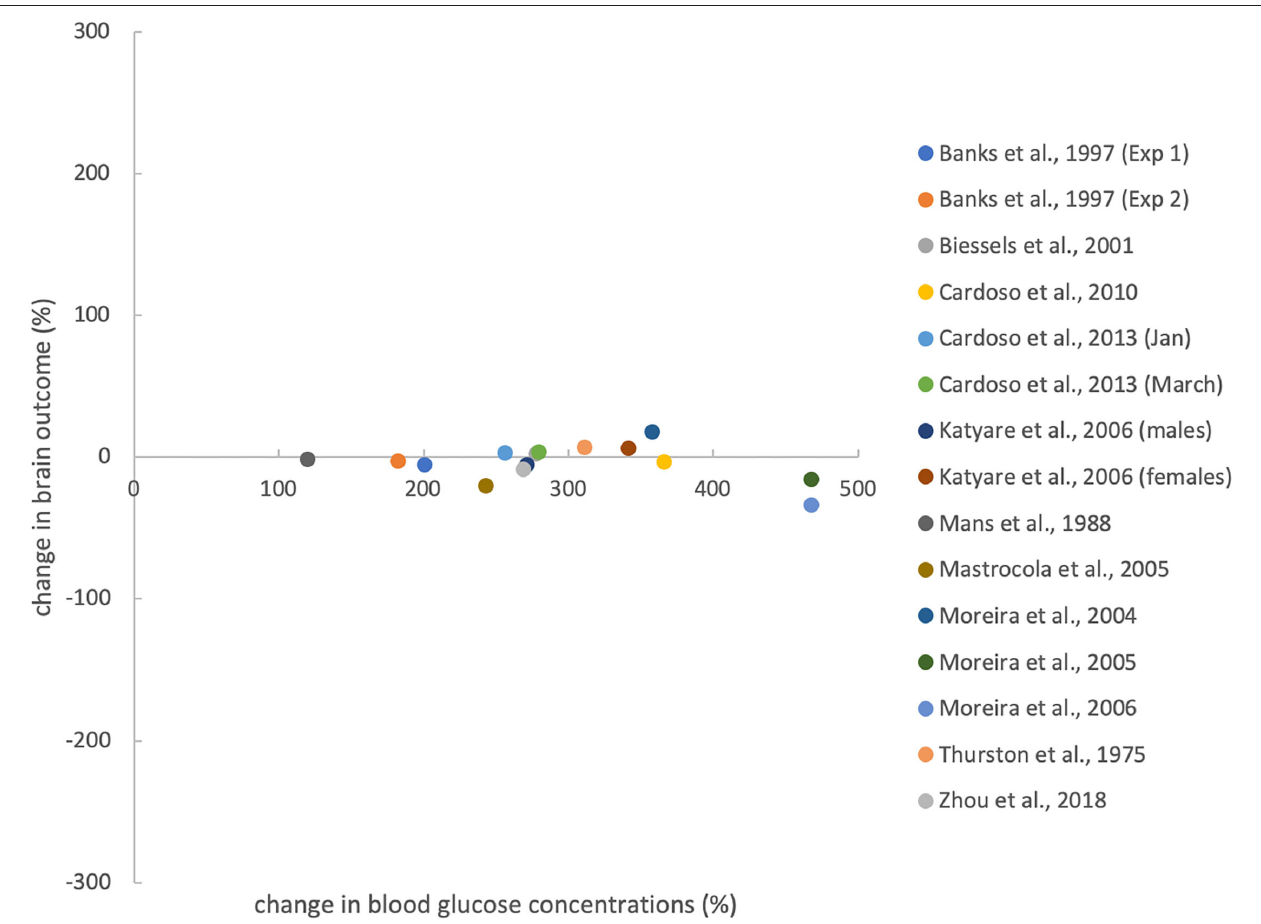
FIGURE 4 | Effects of T1DM induction on percentage change in blood glucose concentration (compared with controls) and brain outcomes. Brain outcomes include brain mass and brain ATP concentrations. Percentage changes were calculated from the data shown in Table 1 . For evaluating Zhou et al.’s work, we pooled brain volume data from 2 groups that differed in cognitive function. Anaesthesia before ATP measurement does not confound the relationship between blood and brain outcomes (see Supplementary Material C